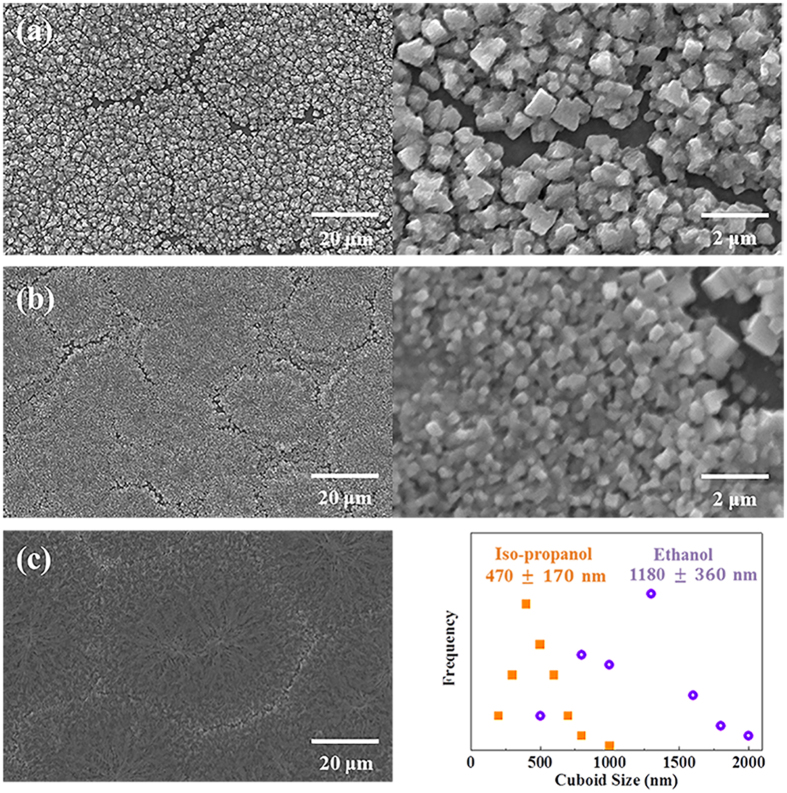
Solvent effects on MAPbI3 using ethanol or isoporpanol.(a) SEM images of MAPbI3 using ethanol, (b) MAPbI3 using iso-propanol, and (c) PbCl2 on mp-TiO2. The average cuboid size is shown for MAPbI3 by ethanol or iso-propanol.